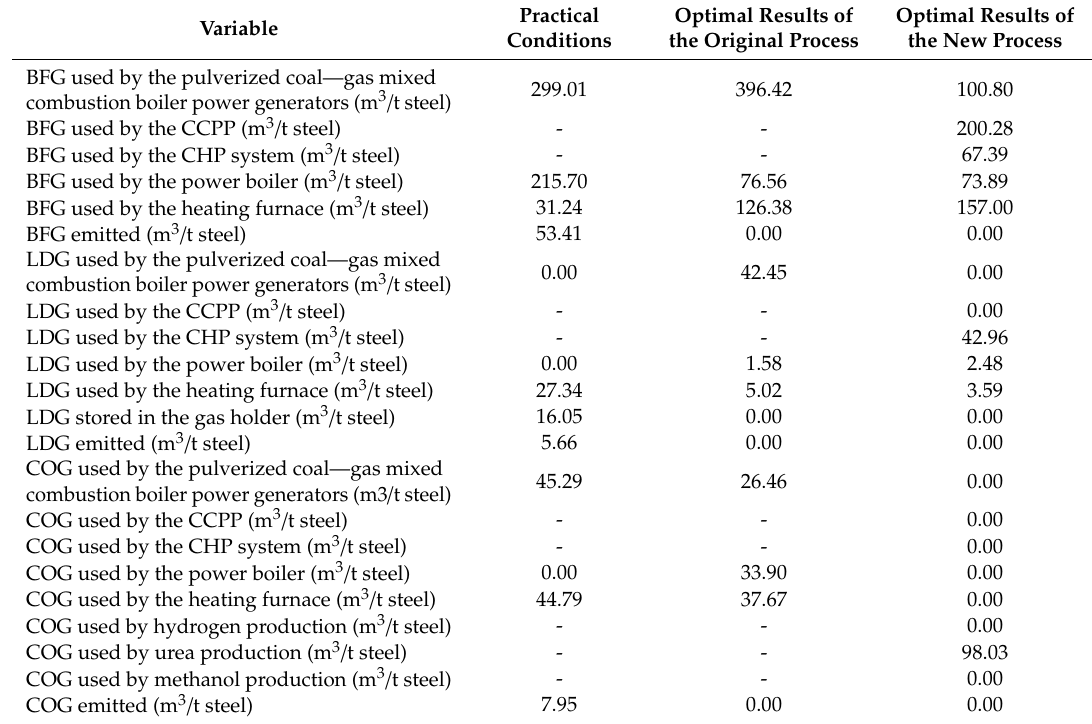
Table 4. Comparison between the model optimization results and practical conditions of byproduct gas distribution. Variable